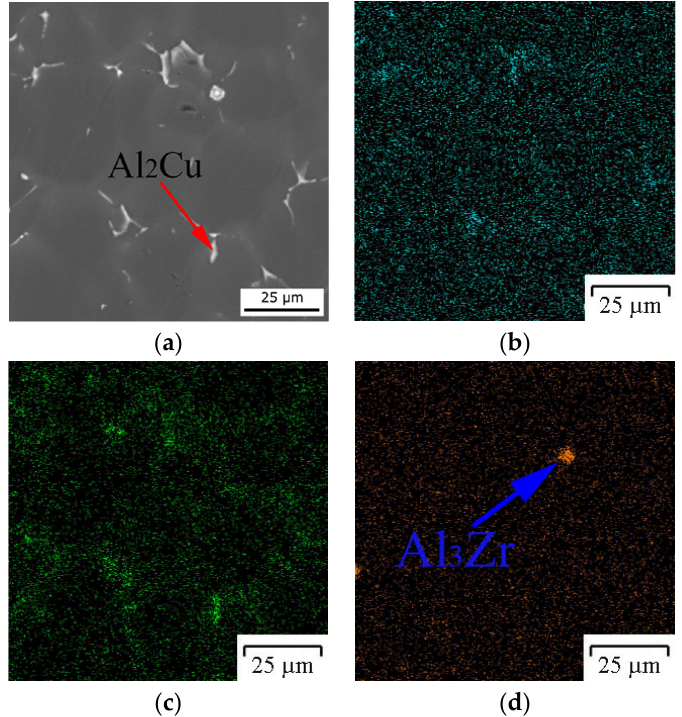
Figure 1. Microstructure ( a ) of electron microprobe analysis (EMPA) mapping ( b – d ) for alloy1.5MnCuZr, as-cast ingot, ( a ) SEM for mapping, ( b ) Mn, ( c ) Cu and ( d ) Zr.